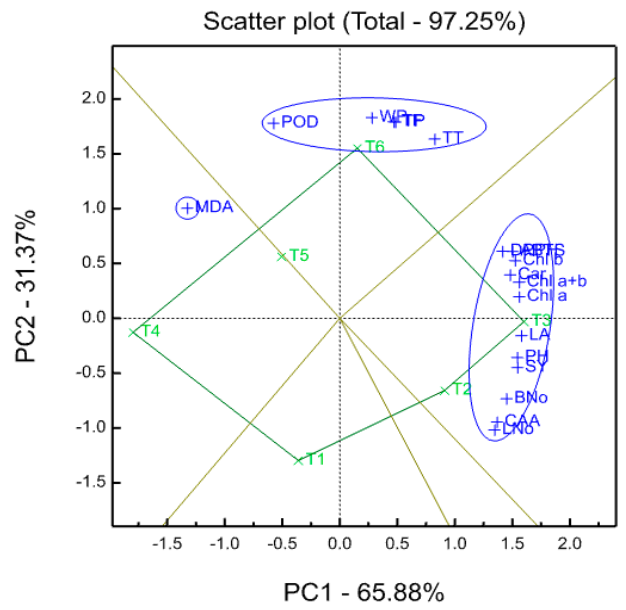
Figure 2. Ordination of treatment by trait biplots of principal component analysis outputs. Treatments in green colour and traits in blue colour. T1, 100% ETc with 0 mg L –1 AsA (WWAsA1); T2, 100% ETc with 200 mg L –1 AsA (WWAsA2); T3, 100% ETc with 400 mg L –1 AsA (WWAsA3); T4, 50% ETc with 0